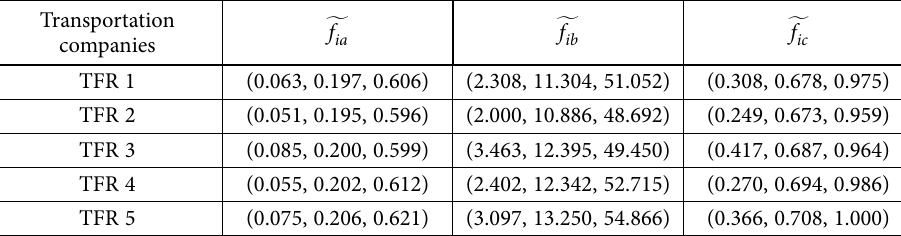
Table 14. The fuzzy appraisal scores Transportation companies